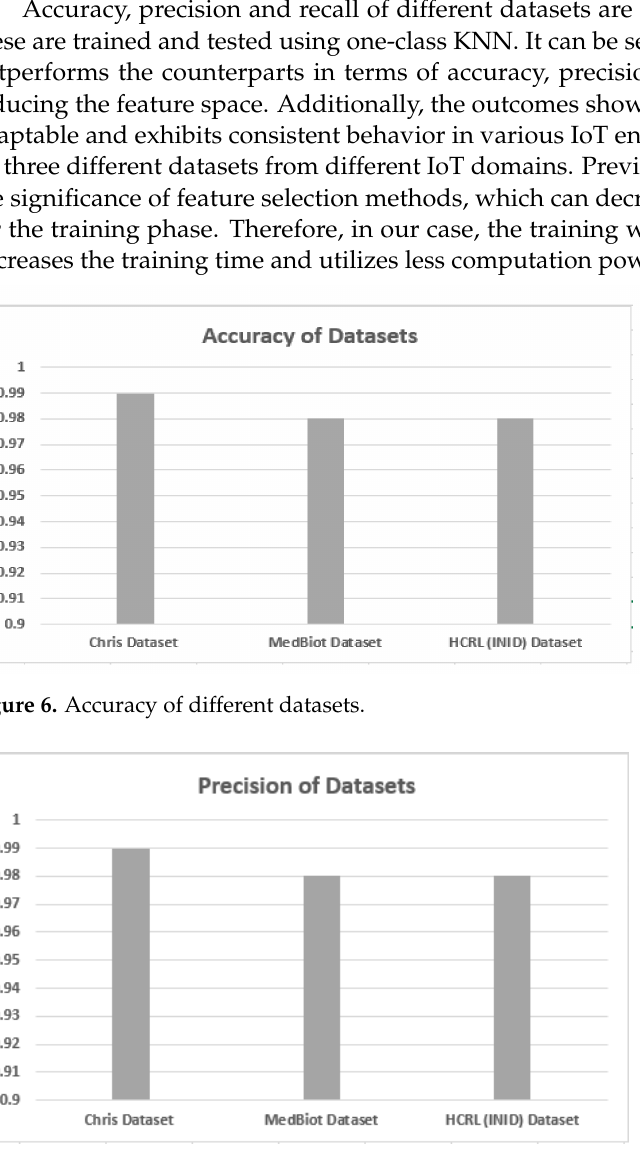
Figure 7. Precision of different datasets.